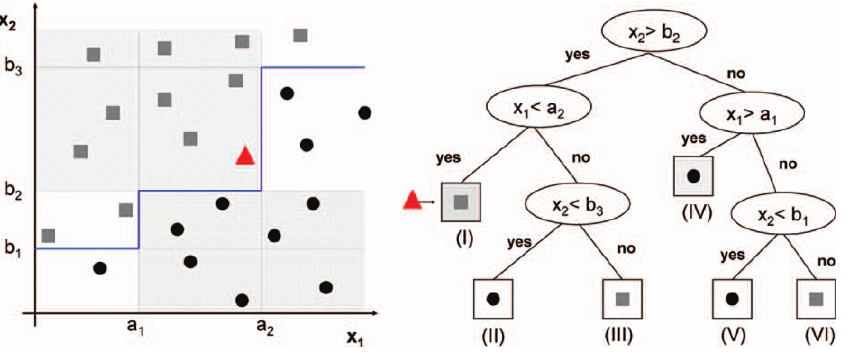
Figure 1. Binary Decision Tree The left panel shows the data for a two-class decision problem, with dimensionality p ¼ 2. The points known to belong to classes 1 and 2 are displayed with filled circles and squares, respectively. The decision boundary is shown as the blue thick line in the left panel. The triangle designates a new point, z , to be classified. The right panel shows the decision tree derived for this dataset whereas the new point z is classified in class 2 (squares). The regions in the input space covered by nodes I and IV in the tree are represented by the dashed areas at the top and bottom of the left panel,